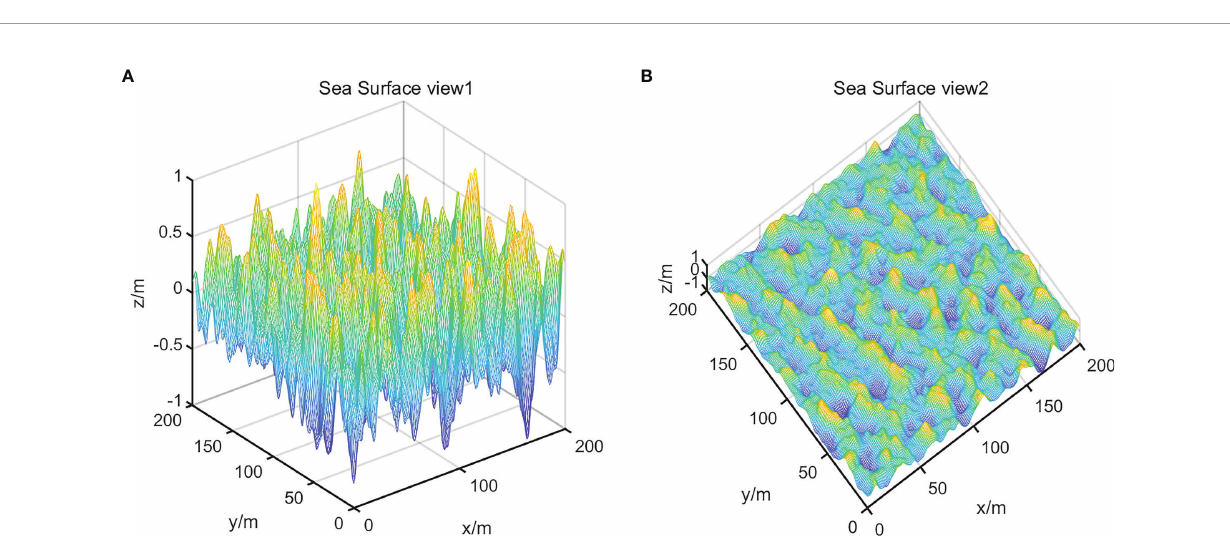
FIGURE 6 | Comparison of the simulated wave spectrum with the target